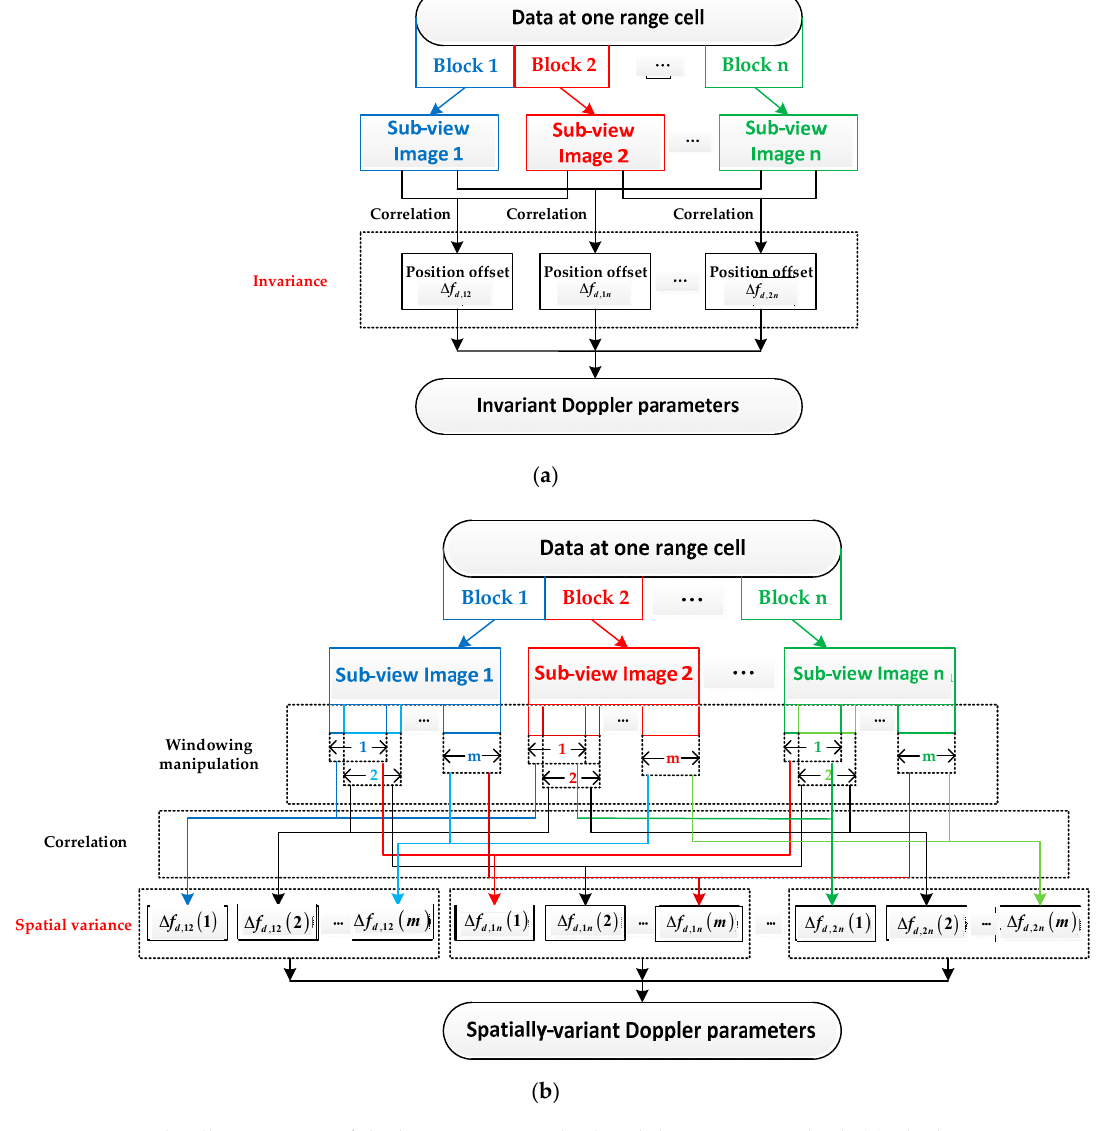
Figure 2. The illuminations of the basic MAM method and the EMAM method. ( a ) The basic MAM method; ( b ) the EMAM method. ∆ f d , ij is the position offset between the sub- i image and sub- j image.